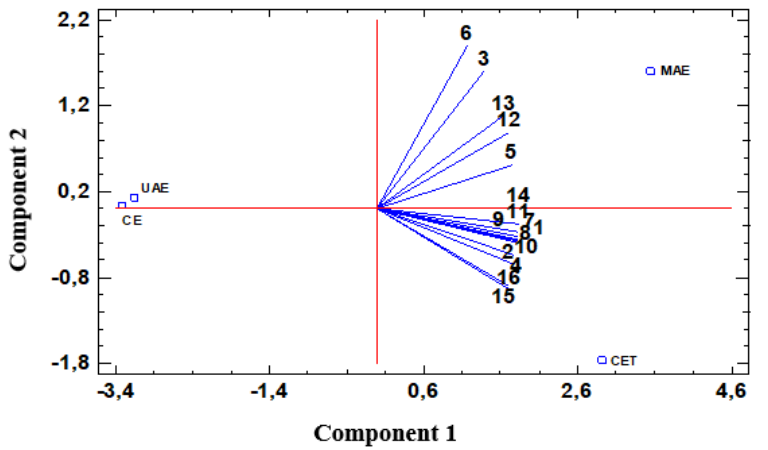
Figure 2. Principal Component analysis (PCA) biplot for the 16 parameters analyzed in Bravo de Esmolfe apple extracts. The first component explained 87.71% of the variance across the different ‘Bravo de Esmolfe’ apple extracts and the second component explained 11.87%.